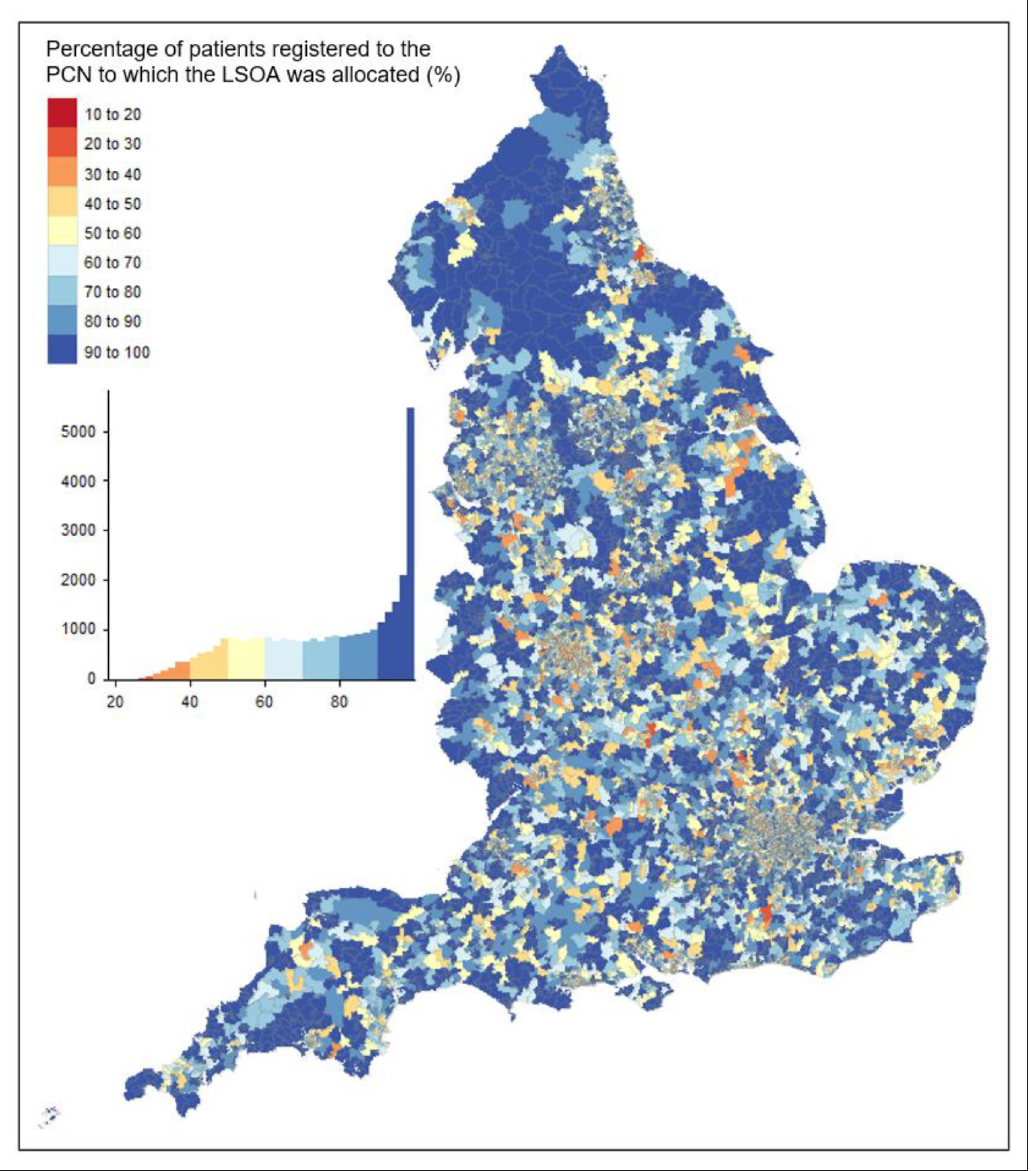
Figure 4 Percentage of residents within each Lower layer Super Output Area (LSOA) registered to a GP practice in the primary care network (PCN) catchment to which the LSOA was assigned Footnote: the unit of geography displayed is the